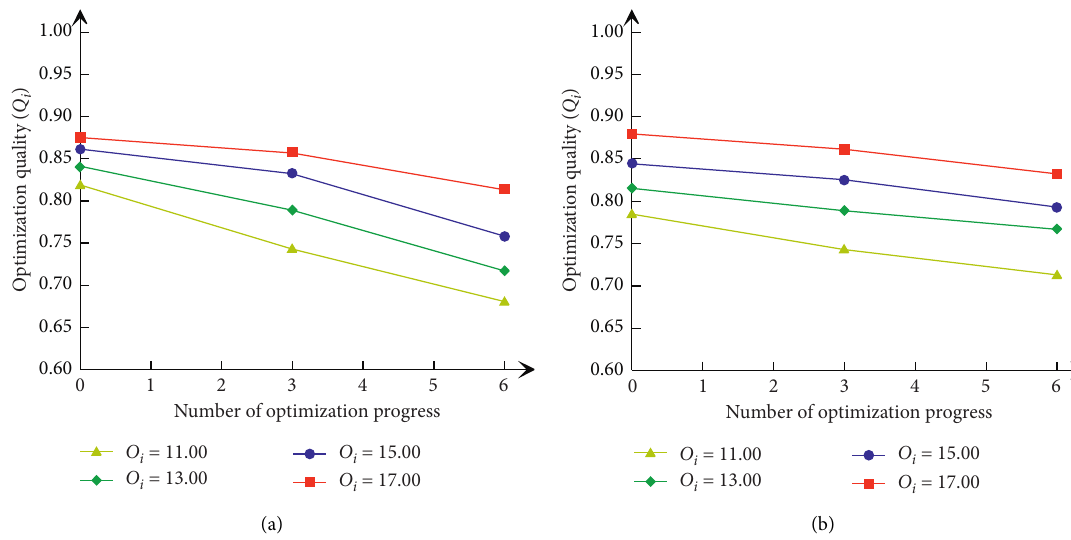
Figure 6: Relationship between optimization quality and the number of optimization progress with different optimization coefficients ( O in the linear (a) and nonlinear management model